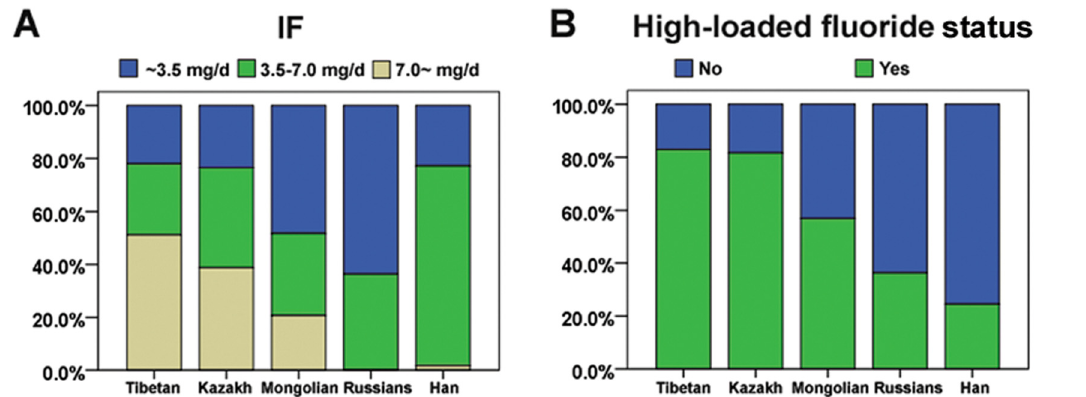
Fig 1. The fluoride exposure and IF in different ethnical brick tea type of fluorosis.